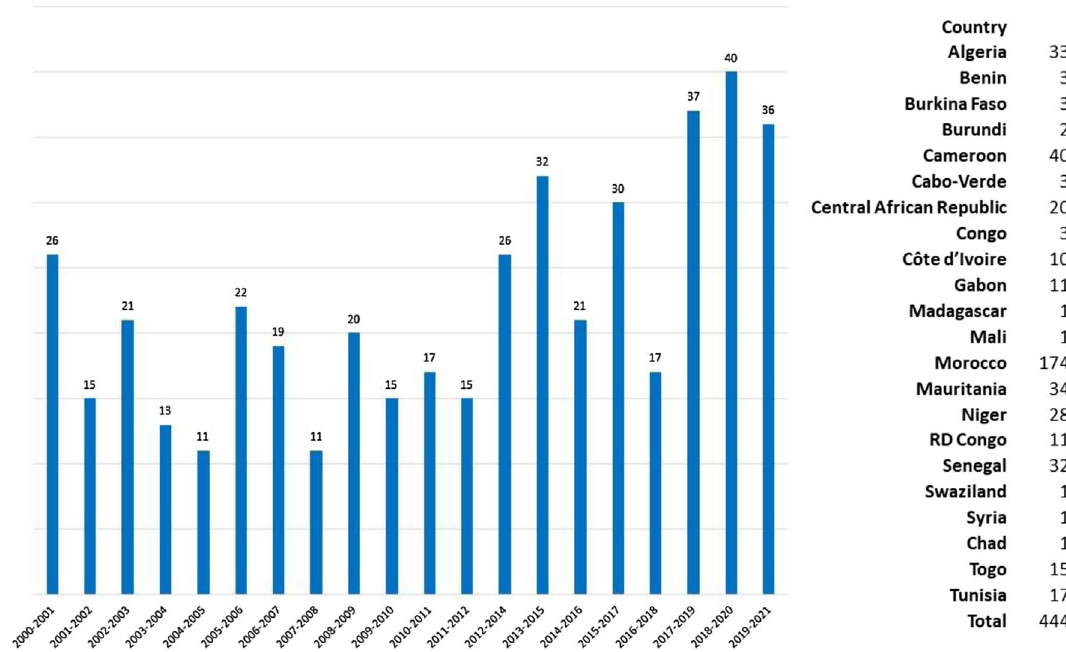
Fig. 4. Number of trainees participating in CRASTE-LF courses per year and per country since 2000. Table 3. Examples of capacity building schools organized by SCOSTEP.